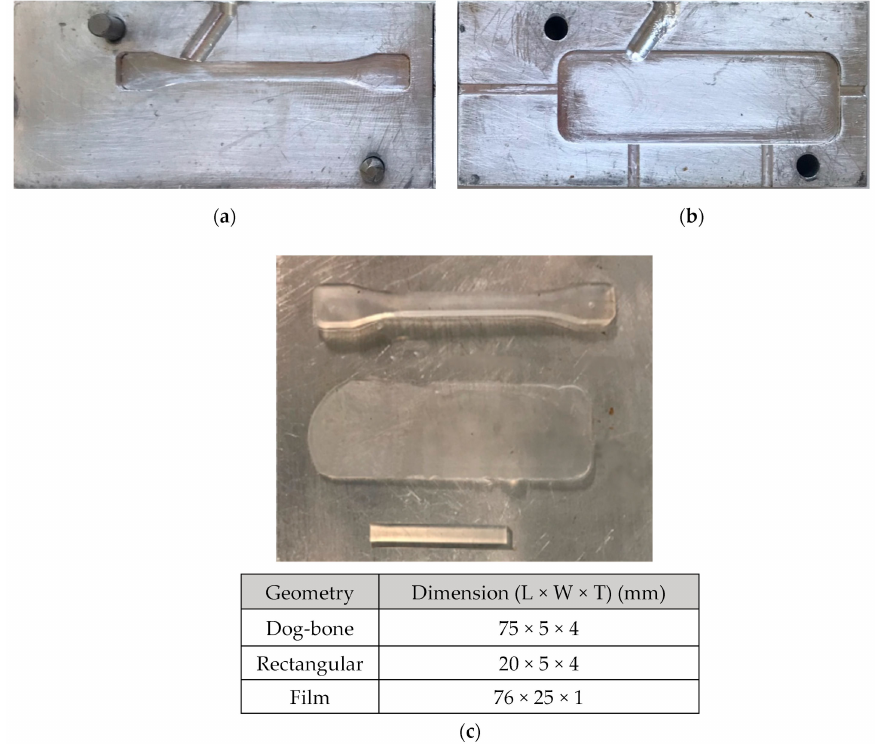
Figure 2. ( a ) The dog-bone mold and ( b ) the film mold and ( c ) the dog-bone specimen, the film, and the rectangular specimen, from top to bottom with their respective dimensions, used for characteristic tests and projectile tests of PEMAA